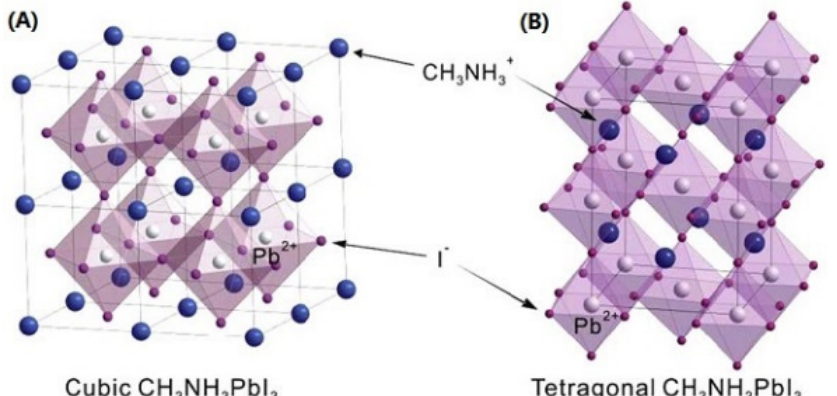
Figure 1. Cont. Figure 1.